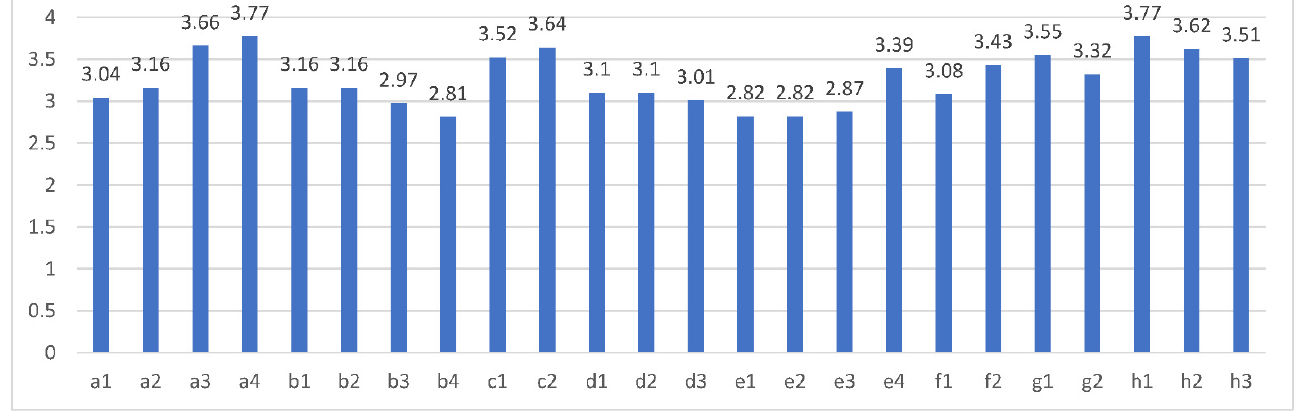
Figure 3. Mean values of measurable variables. Table 10. Frequency statistics of control